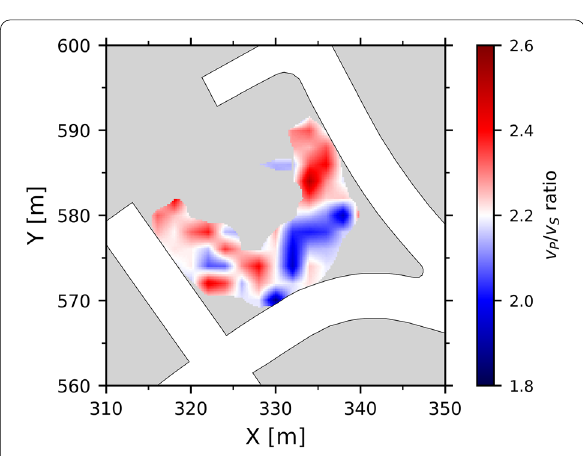
Fig. 8 v P / v S ratio masked by the DWS threshold of v P and v S